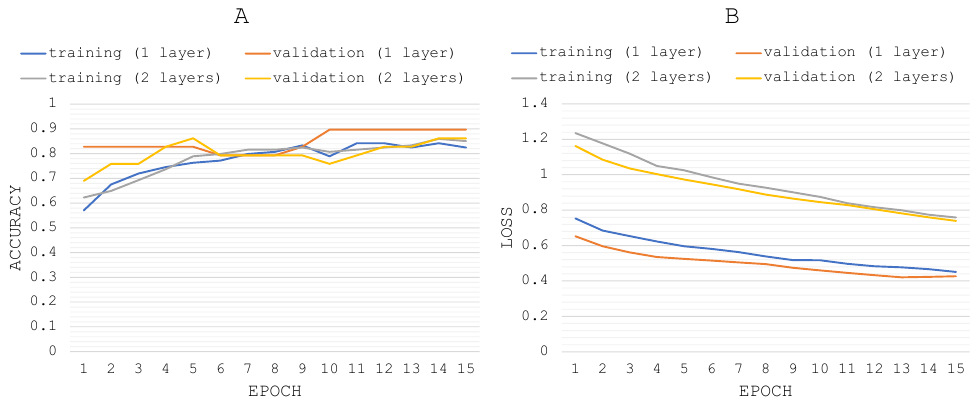
Figure 5. Loss and accuracy results of ANN models; ( A ): training and validation accuracy; ( B ): training and validation loss; the compilation and fitting parameters were arbitrarily config- ured; compilation: loss = ’binary_crossentropy’, optimizer = ’adam’ and metrics = ’accuracy’; Fitting: batch_size = 32, epochs =